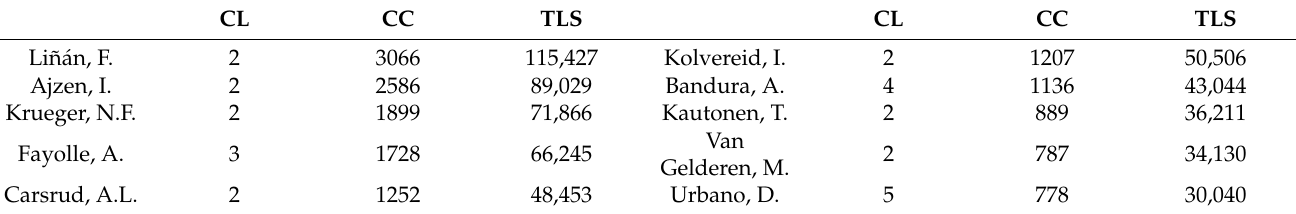
Table 7. EI: Co-citation and total link strength of the top 10 most cited authors. CL